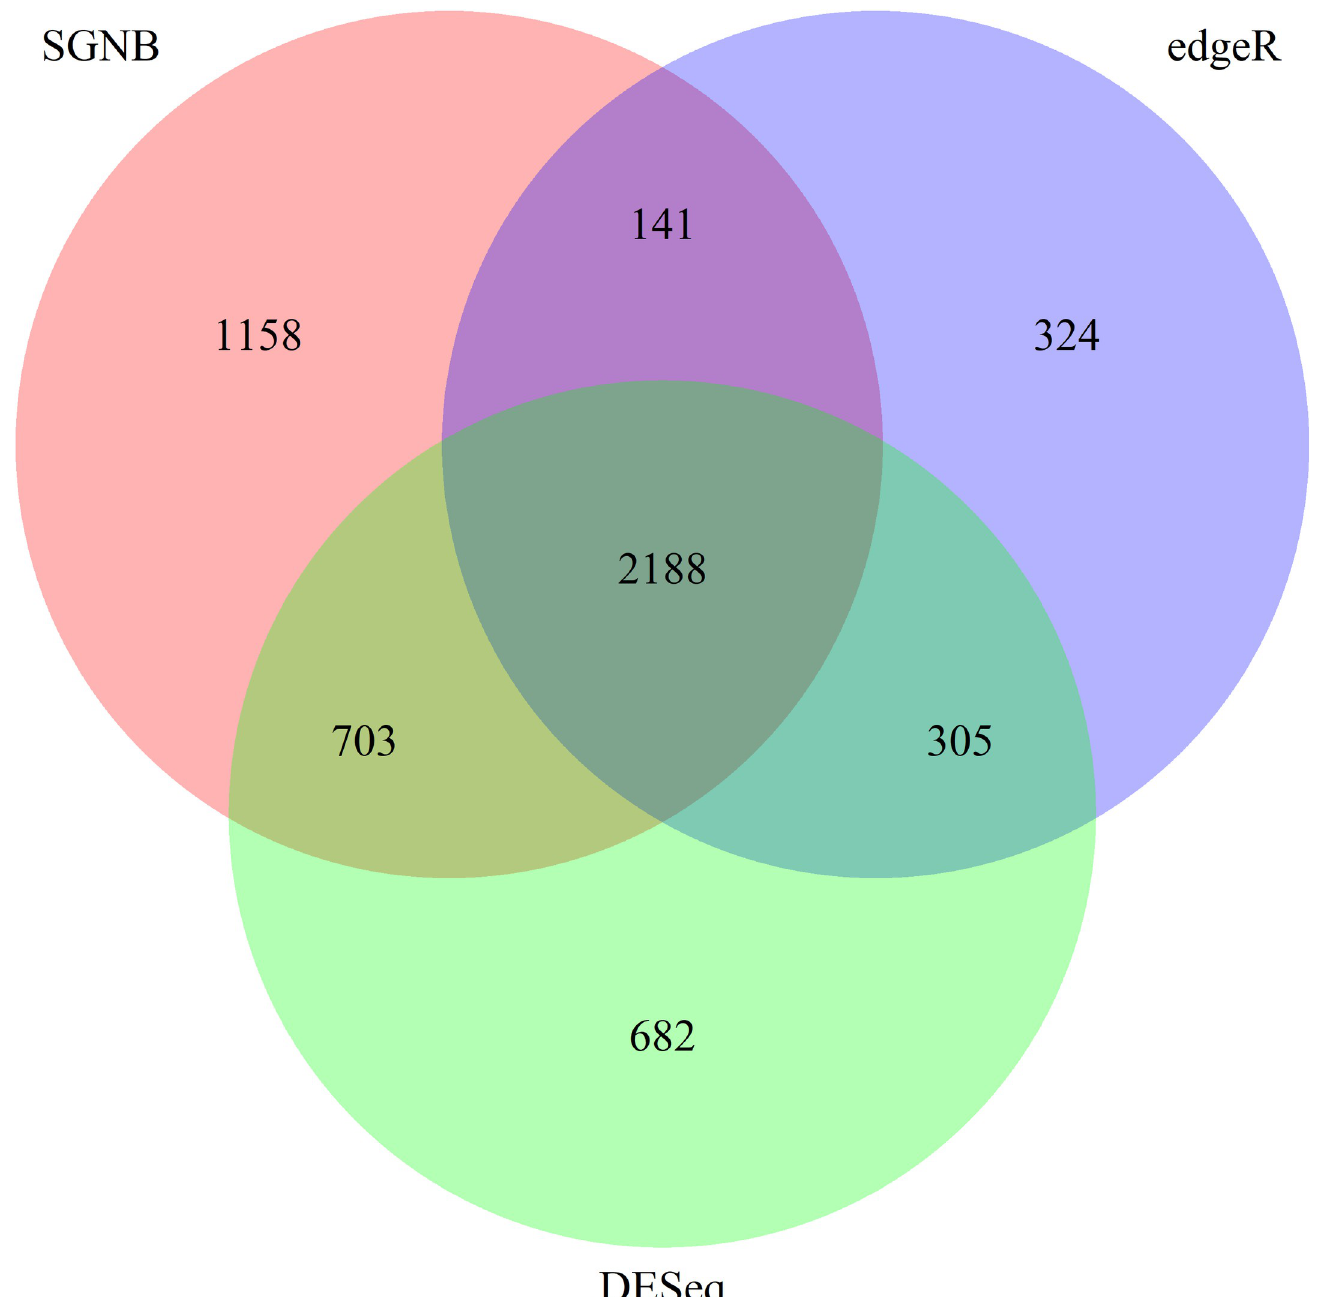
Fig 11. Venn diagram of DE genes detected using different methods and controlling FDR at 5% [18].